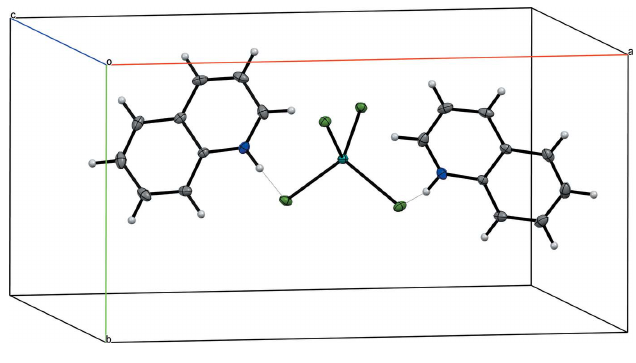
Figure 2 ORTEP representation of the title compound showing the intermolecular hydrogen bonds as dotted lines. Displacement ellipsoids correspond to 30% probability.